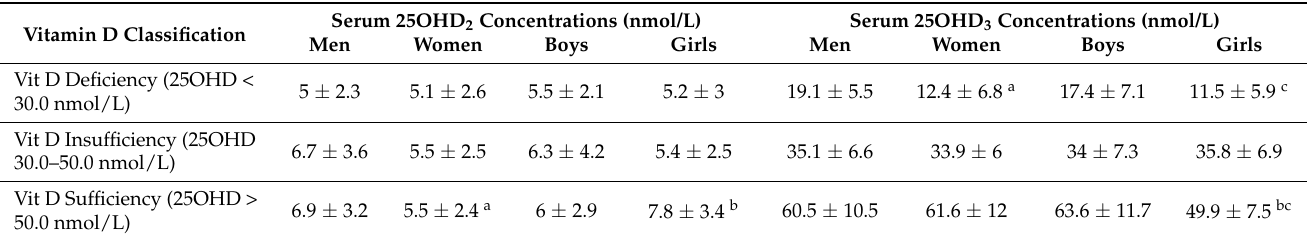
Table 3. Serum 25OHD 2 and 25OHD 3 concentrations (nmol/L) stratified by vitamin D status, gender, and